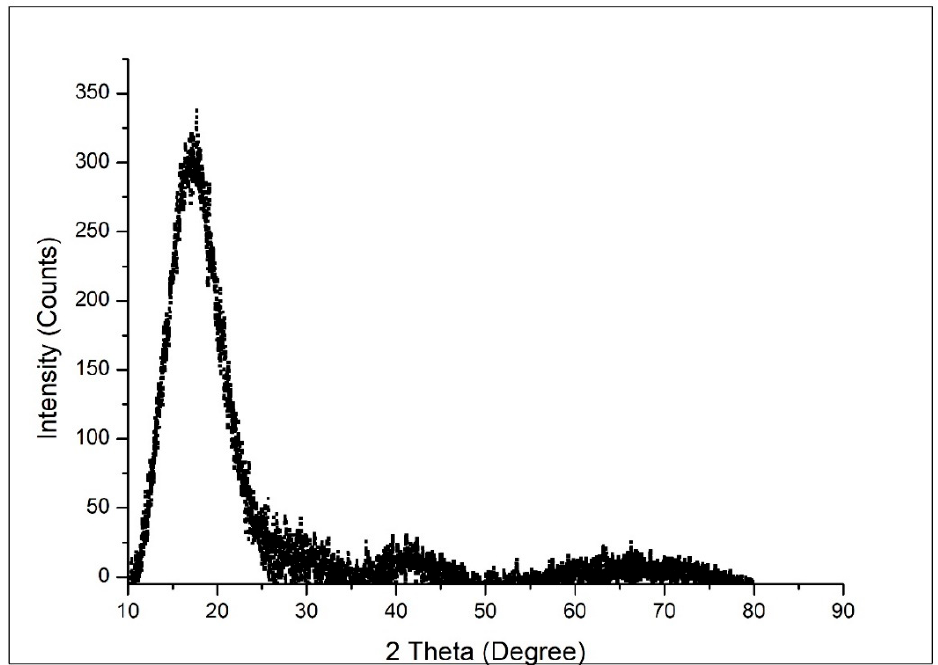
Figure 3. XRD Figure 3. XRD spectrum.